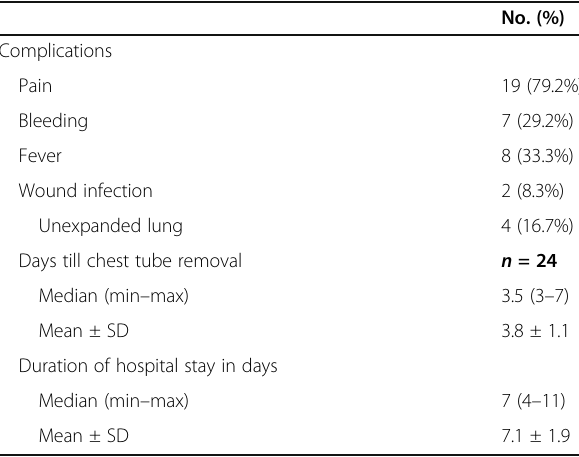
Table 2 Distribution of the studied cases according to complications and duration of hospital stay ( n = 24)